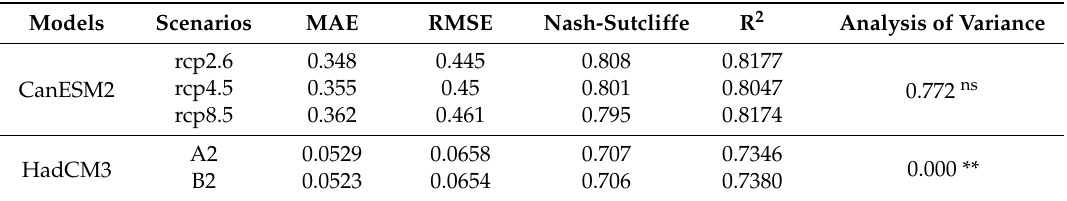
Results of the efficiency evaluation of the used scenarios for the daily mean temperature predictions.